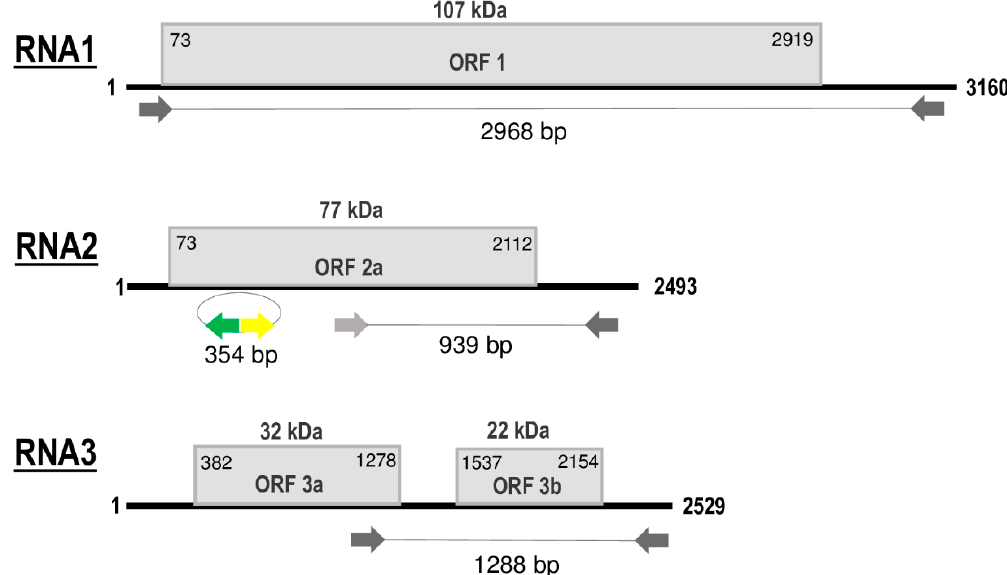
Figure 2. Schematic representation of genomic RNA segments of grapevine line pattern virus (GLPV). open reading frames (ORFs) are indicated as boxes on each segment. Initiation and termination positions of the coding regions are indicated above each box. Expression product of each RNA [1a (Methyltransferase \ Helicase, MTR-HEL); 2a (RNA-dependent RNA Polymerase, RdRP), 3a (Movement protein, MP) and 3b (Coat protein, CP)] is reported inside the boxes. The molecular weight predicted for each protein is reported above boxes. Amplified parts which were used in the RT-PCR and Northern validation are also indicated. Figure not drawn to scale.